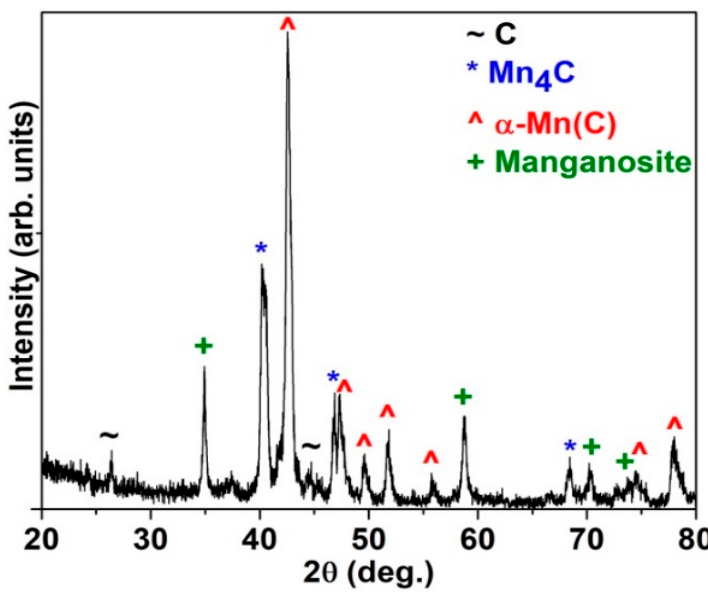
Figure 1. The XRD patterns of Mn–C nanoparticles can be indexed with α -Mn(C), Mn 4 C, manganosite, and trace amount of C.